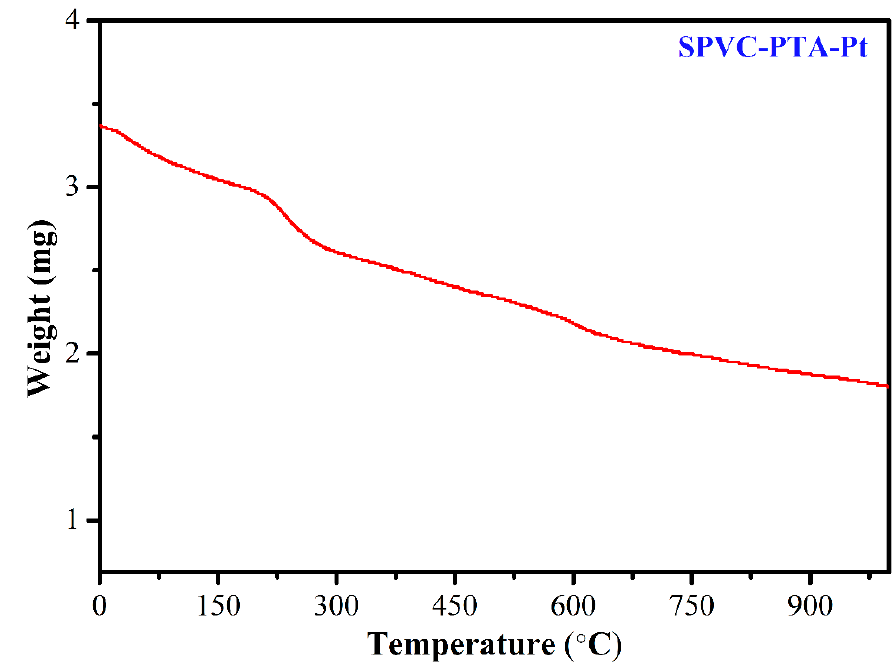
Figure 9. TGA curve of the SPVC–PTA–Pt IPMC membrane.